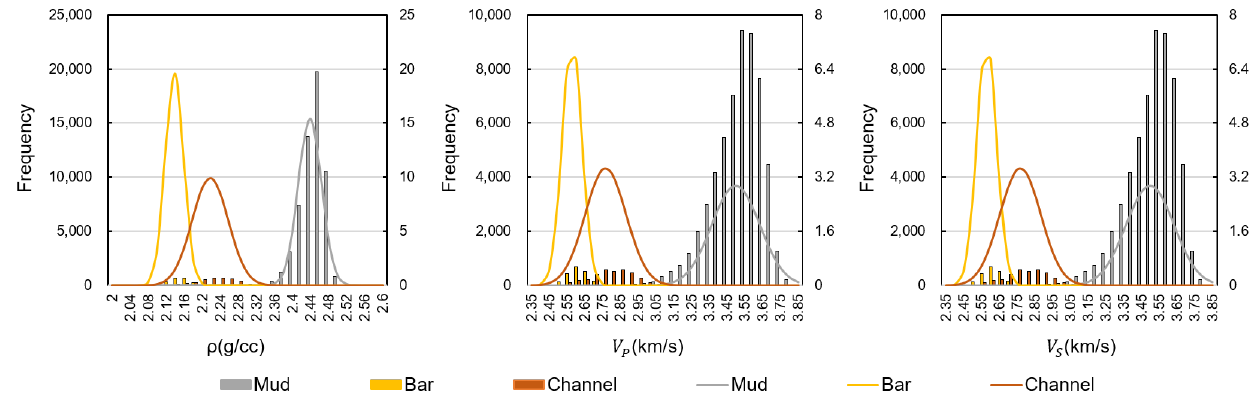
Figure 3. Statistical distribution of the elastic parameters of the different microfacies.